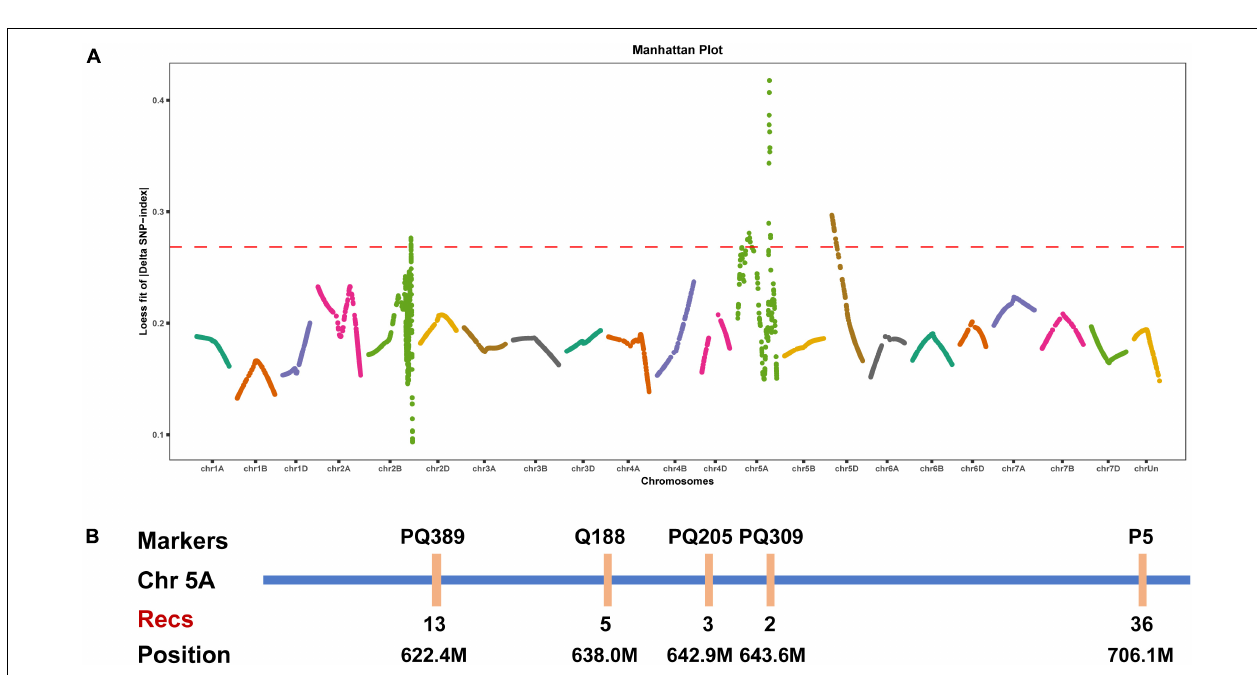
FIGURE 1 | Phenotypic analyses of the wheat lines used in this study. (A) Phenotype of the speltoid spike mutant je0275 at the heading stage. Bars, 10 cm (left) and 2 cm (right). (B) The plant heights, spike lengths, numbers of fertile spikelets per spike and spikelet densities of je0275 and WT plants, grown in approximately 10 rows, were measured. The data are presented as the mean, and the error bars indicate the SD. *** and **** indicates significant differences at the 0.001 and 0.0001 level (Student’s t- test), respectively.